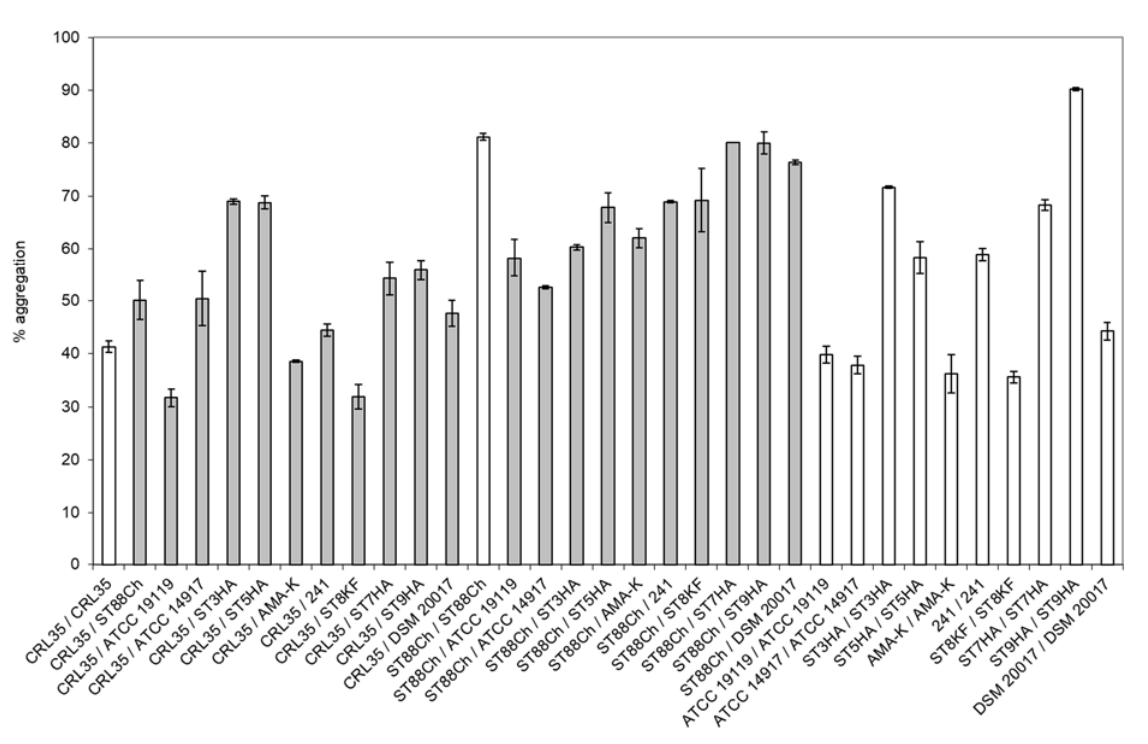
Figure 1. Aggregation (auto-aggregation (white bars) and co-aggregation (grey bars)) properties between CRL35: E. mundtii CRL35; ST88Ch: E. faecium ST88Ch; ATCC 19119: L. ivanovii subsp. ivanovii ATCC 19119; ATCC 14917: Lb. plantarum ATCC 14917; ST3HA: P. pentosaceus ST3HA; ST5HA: E. faecium ST5HA; AMA-K: Lb. plantarum AMA-K; 241: Lb. curvatus 241; ST8KF: Lb. plantarum ST8KF; ST7HA: Enterococcus spp. ST7HA; ST9HA: Pediococcus spp. ST9HA; DSM 20017: Lb. sakei subsp. sakei DSM20017. The results represent the average of three independent experiments, and SD are in ‐ cluded.